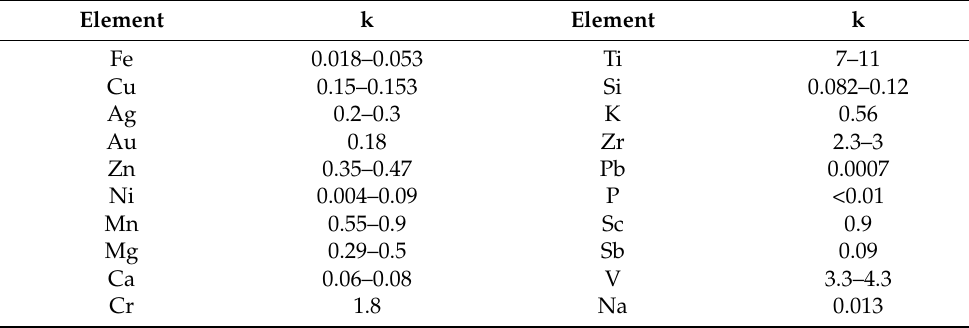
Table 1. Distribution coefficients of impurities in aluminum